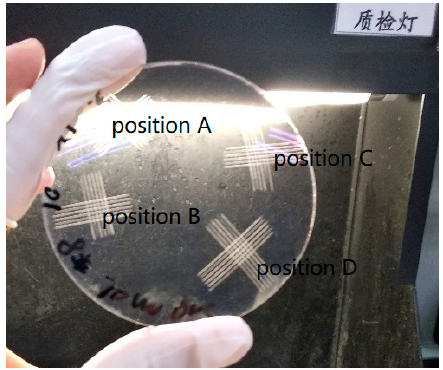
Figure 1. Schematic diagram of 4 positions (grid sets) on one piece of lens.